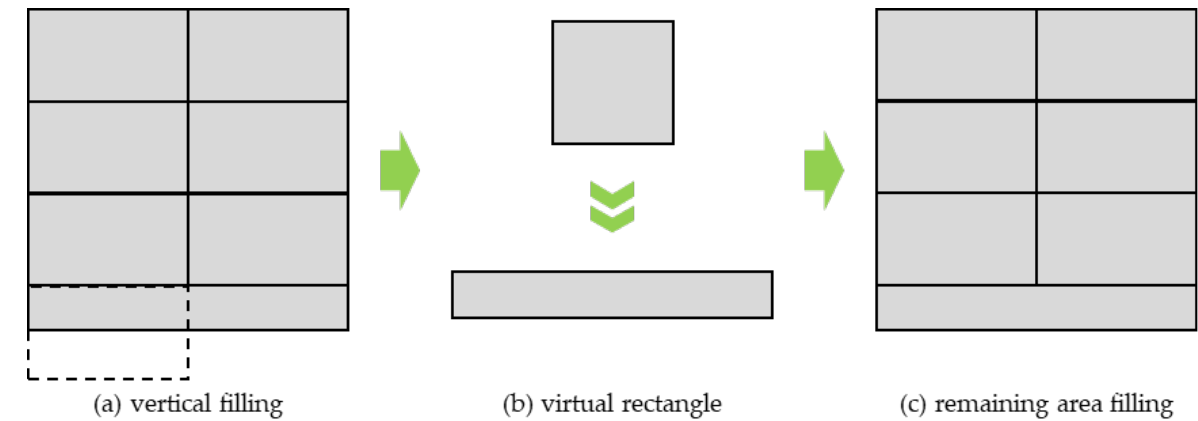
Figure 1. Flowchart for the horizontal filling.